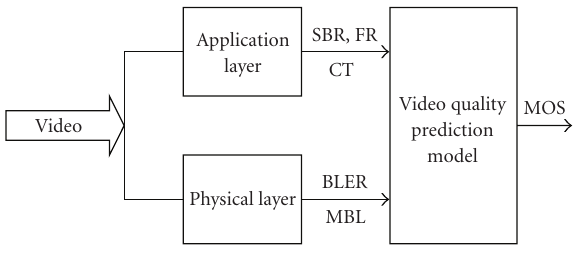
Figure 6: Functional block of proposed video quality prediction